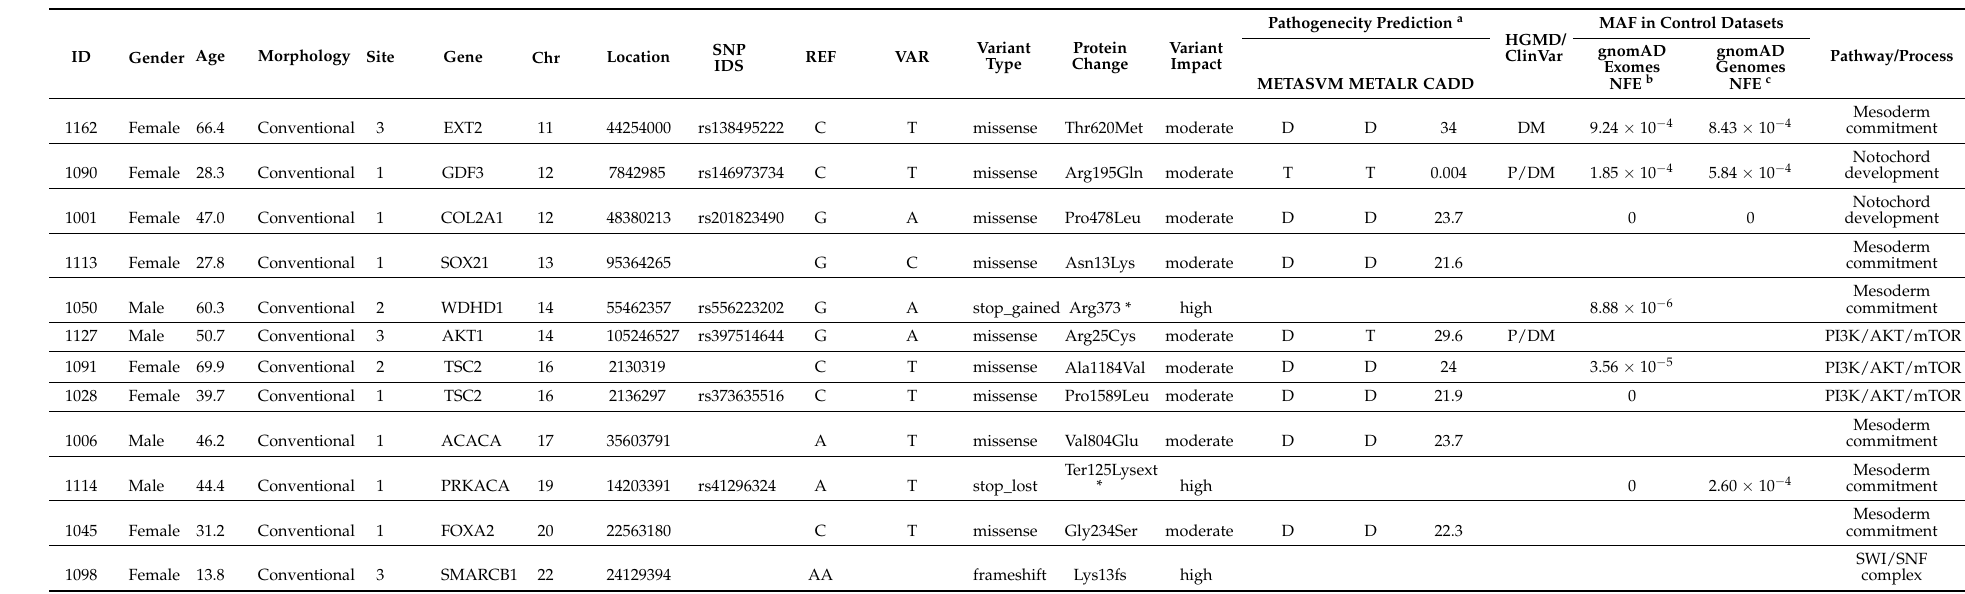
Female 13.8 Conventional 3 SMARCB1 22 24129394 AA frameshift Lys13fs high Site: 1, bones of skull and face and associate joints; 2, pelvic bones, sacrum and coccyx and associated joints; 3, vertebral column. Chr, chromosome; REF, reference allele; VAR, variant allele; Freq, frequency; MAF, minor allele frequency; T, tolerant; D, deleterious; P, pathogenic; DM, disease-causing mutation. a Pathogenicity prediction for missense variants based on in silico algorithms, METALR and METASVM, which are ensemble prediction scores that incorporate results from nine algorithms and allele frequency. CADD was also applied. b,c Genome Aggregation Database (gnomAD) exomes and genomes, respectively, in non-Finnish European population